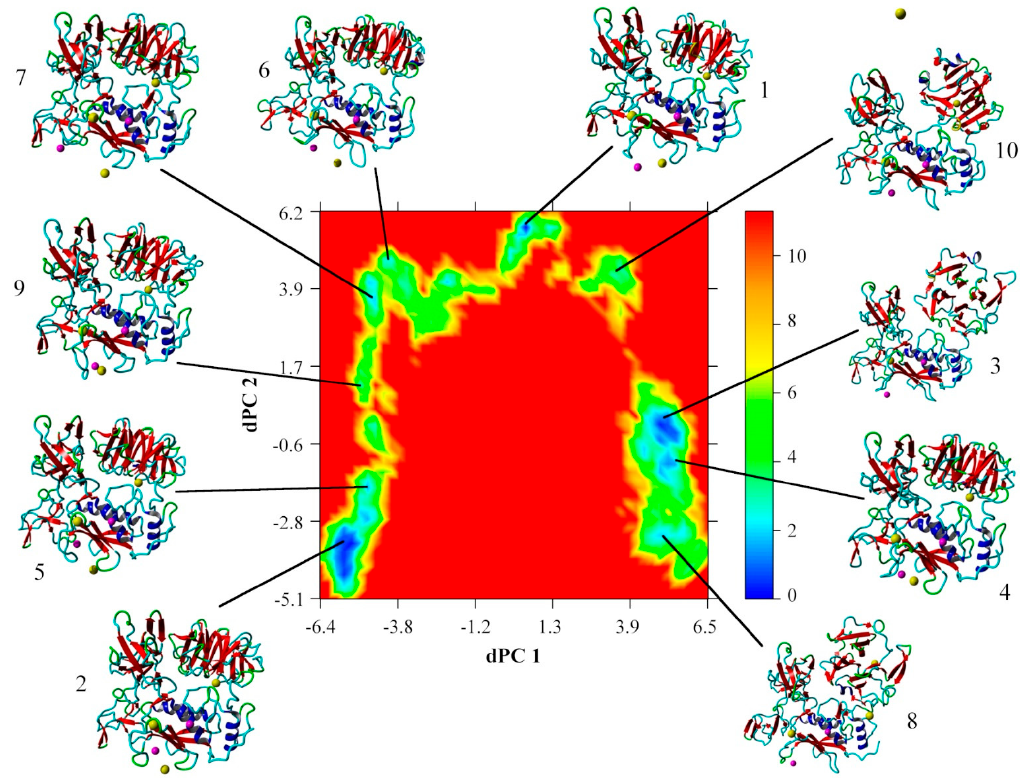
Figure 3. Free energy landscape (kJ mol − 1 ) as a function of the first two dihedral principle components (dPC1 and dPC2); the lowest energy conformations of each family as identified by k-means clustering are shown. Secondary structural motifs and ions are shown (blue, α -helix; red, β -sheet; green, β -turn / bend; aqua, coil; pink, Zn 2+ ; and yellow, Ca 2+ ). Table 3. Average RMSF of the associated divalent cations to the C α -trace of MMP-2 a .